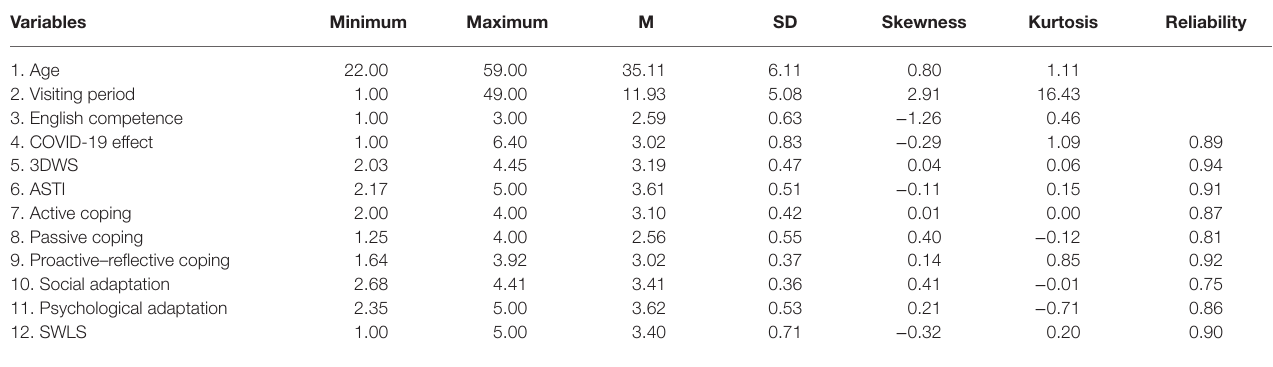
TABLE 1 | Minimum, maximum, means, SDs, skewness, kurtosis, reliability. Variables Minimum Maximum M SD Skewness